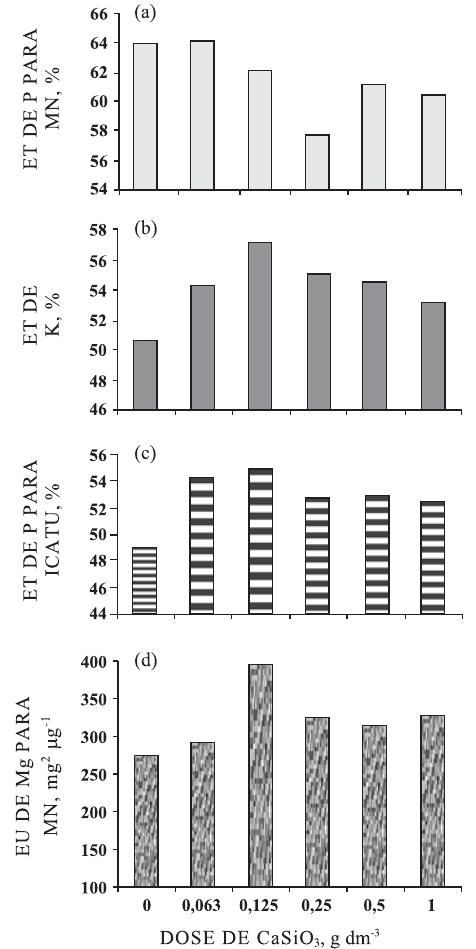
Figura 1. Eficiência de translocação (ET) de P para a variedade Mundo Novo (MN) (a), ET média de K no cafeeiro (b), ET de P para Icatu (c) e eficiência de uso (EU) do Mg para a variedade Mundo Novo (MN) (d), em função das doses de silicato de cálcio (CaSiO ) aplicadas ao substrato 3 de